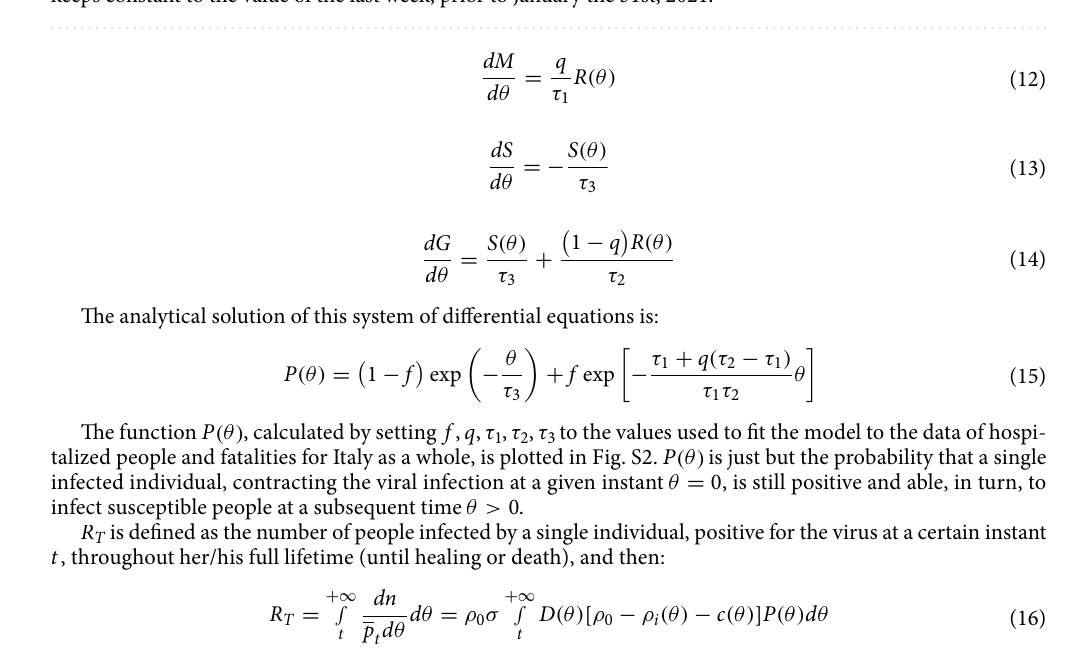
Figure 6. Simulation of the number of hospitalized people and of fatalities due to the increase of people mobility at the level experienced at the end of summer 2020, according to the time evolution of the diffusion coefficient shown in Fig. S1. Calculations in ( a ) and ( b ) were performed in the absence of vaccination, whilst in ( c ) and ( d ) we the effect of vaccine immunization is included assuming that the average vaccination daily rate keeps constant to the value of the last week, prior to January the 31st,